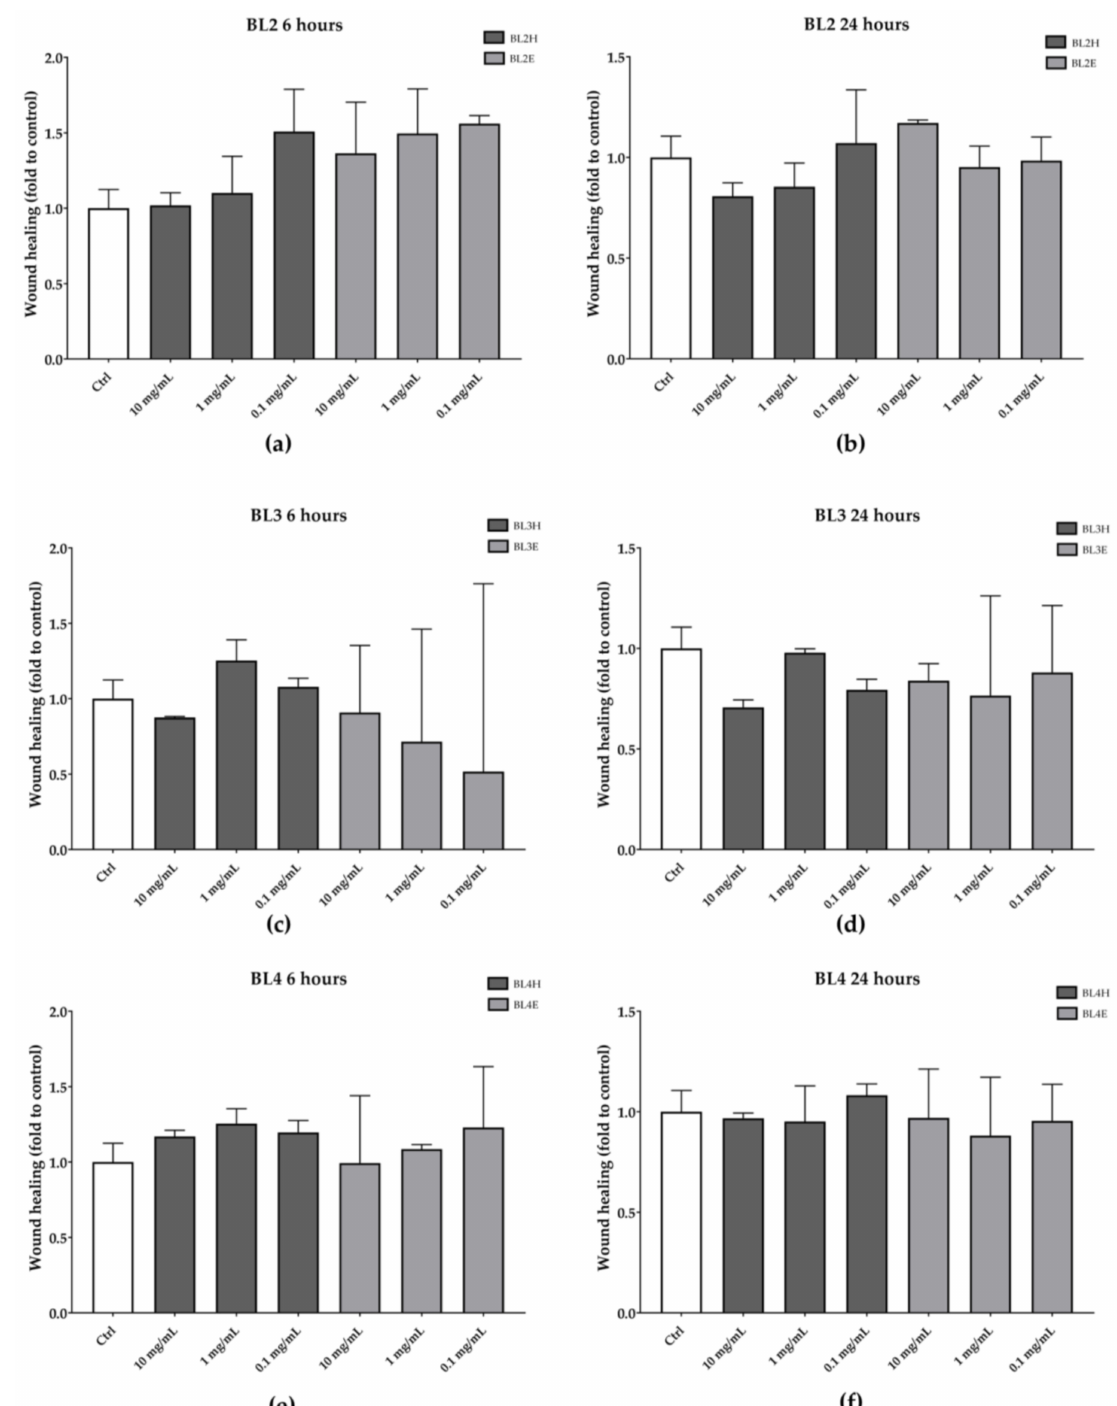
Figure 4. Wound-healing activity of BL2 ( a , b ), BL3 ( c , d ), and BL4 ( e , f ) honeys and extracts after six hours (left) and 24 h